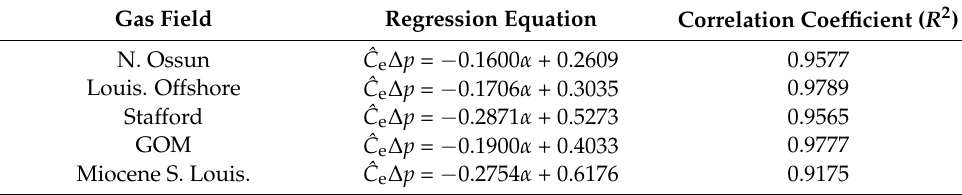
Table 2. Gas reservoir relational regression equation of Ĉ e Δ p and α ( α ≥ 1.2).